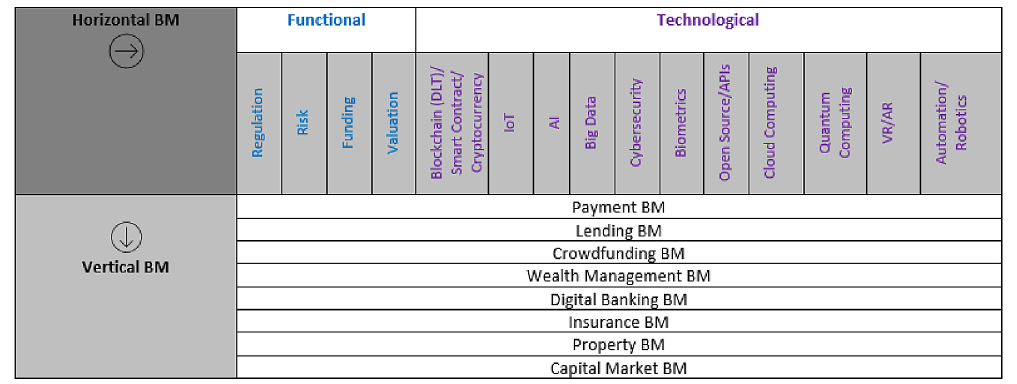
Figure 1. FinTech BMs (verticals and horizontals). FinTech (financial technology); BM (Business model); DLT (Distributed ledger technology); IoT (Internet of things); AI (Artificial intelligence); API (Applications interfaces); VR (virtual reality); AR (augmented